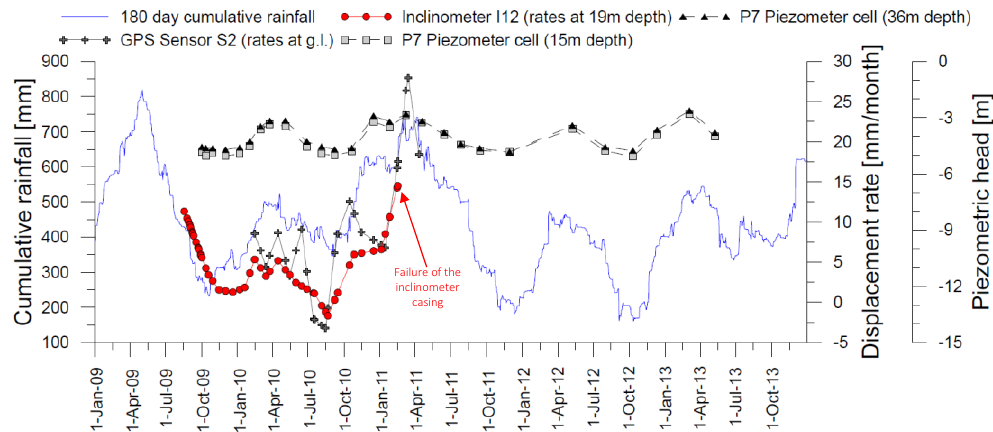
Figure 3. The 180-day cumulative rainfall (weather station located in Melfi, 3 km far from the Pisciolo slope), piezometric levels at both 15 m and 36 m depths (vertical P7 in Figure 1) and displacement rates measured at 19 m depth (inclinometer I12 in Figure 1) and at the ground level (GPS S2 in Figure 1); data from [3] and new data.